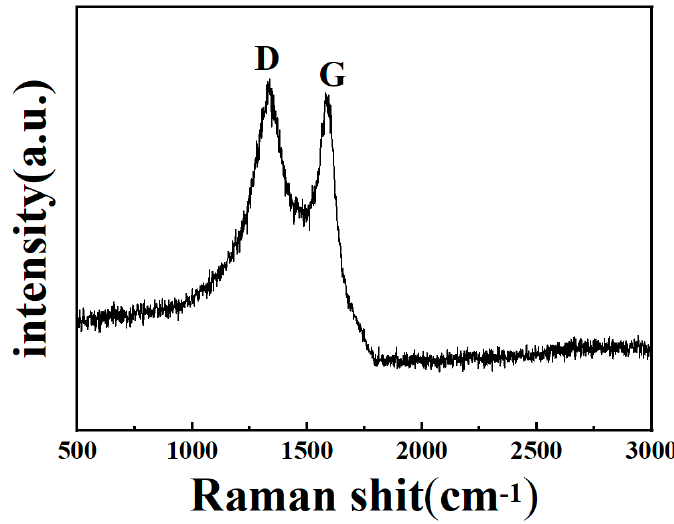
Figure 3. The Raman spectrum of CLR －